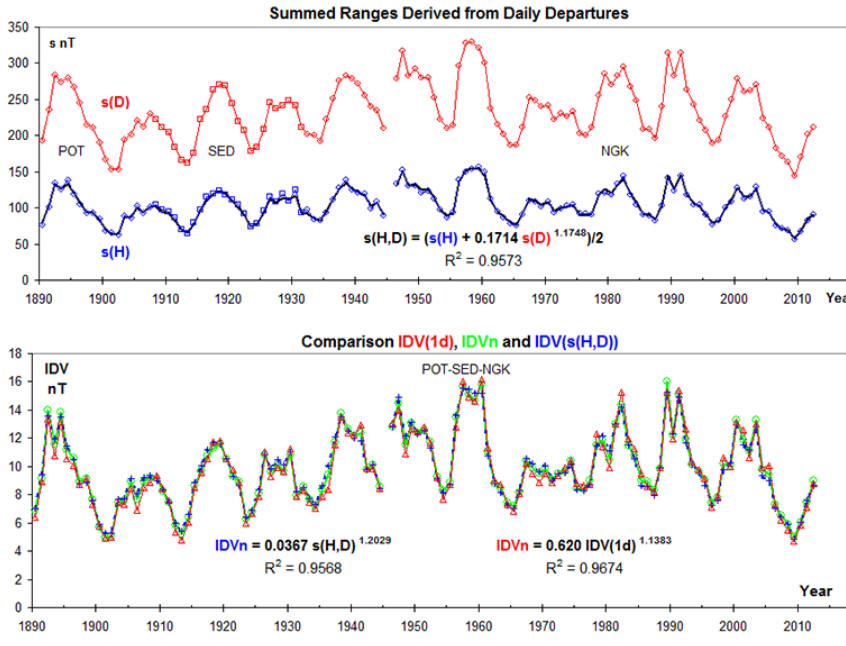
Figure 2. (Upper panel) Summed ranges derived from daily departures for declination s(D) (red curve) and horizontal force s(H) (blue curve) for the combined POT-SED-NGK series. Each station’s yearly value is marked with a different symbol (POT diamond, SED square, NGK circle). The break in 1945 was caused by interruptions stemming from the Battle for Berlin during the final phase of WWII. The composite s(H,D) is added over s(H) as a black line. It is difficult to distinguish between the blue and the black lines. It is rare in this business to find such close